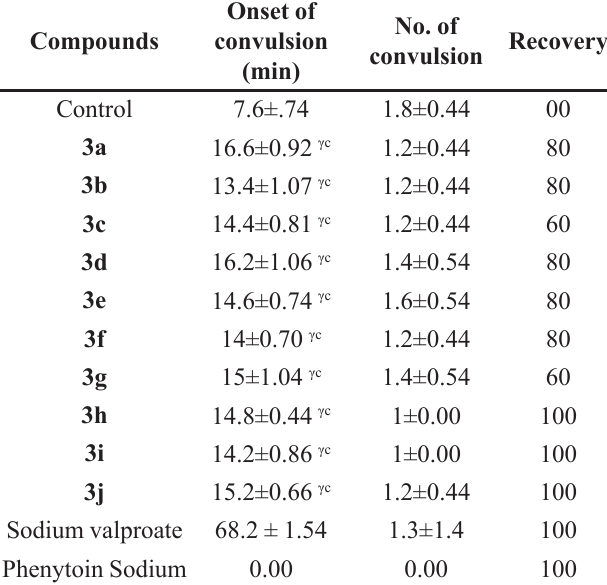
TABLE IV - Anticonvulsant activities of 6-aryl-2-(imidazol-1-yl / against pentyleneteterzole (PTZ) induced method